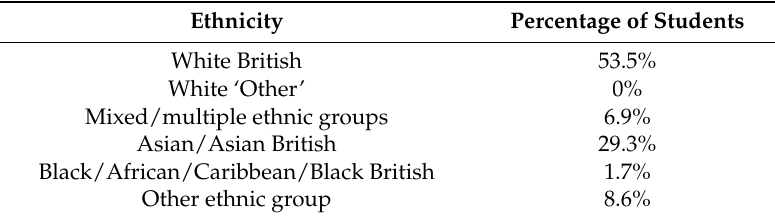
Table 3. The ethnicity of